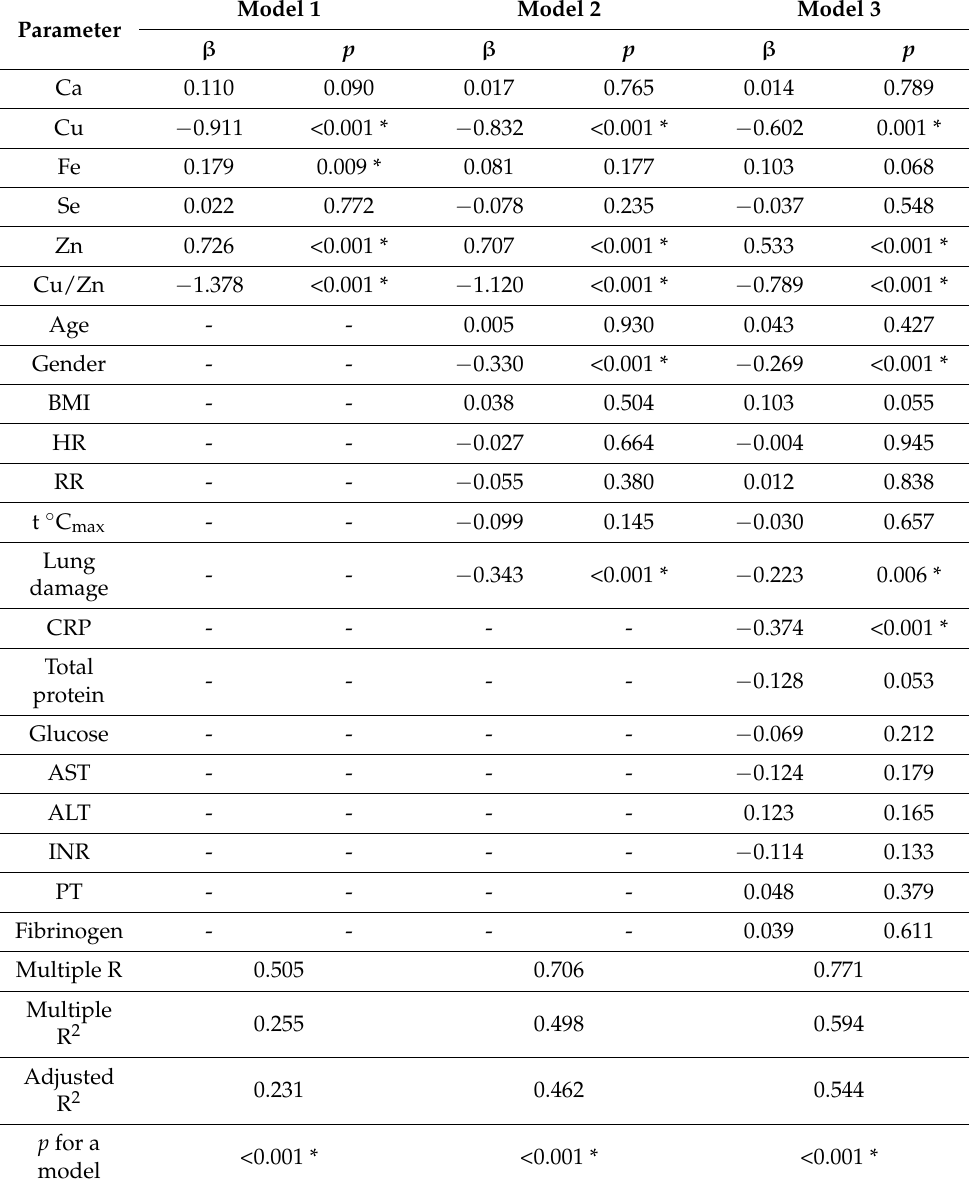
Table 3. Multiple regression analysis of the association between blood oxygen saturation (SpO 2 ) (dependent variable) and serum metal levels (Model 1) after adjustment for anthropometric and clinical variables (Model 2), and biochemical and hemostatic markers (Model